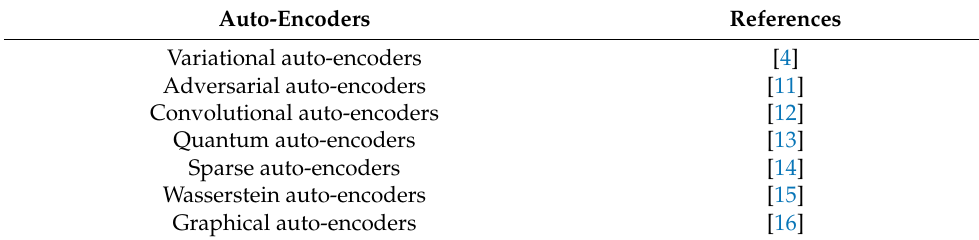
Table 1. Some of the theoretical frameworks of traditional